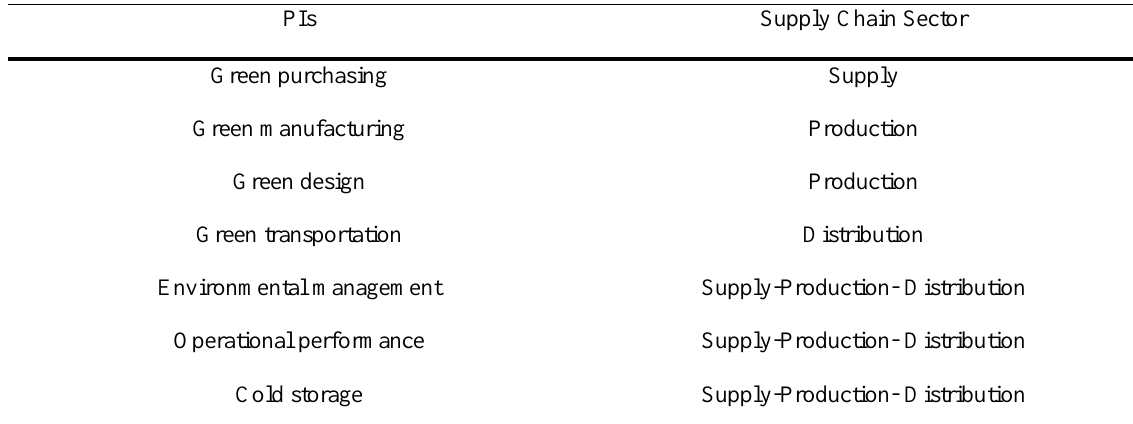
Table 1. Performance indicators of green supply chain.